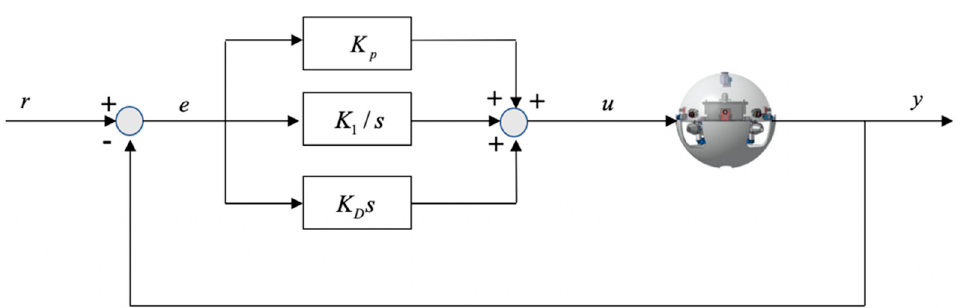
Figure 6. Architecture of the Proportion Integral Differential (PID) controller.